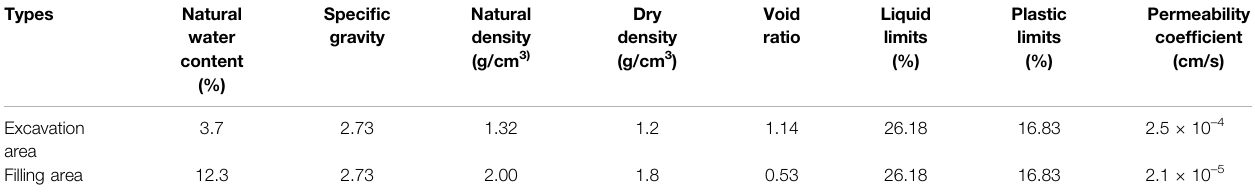
TABLE 1 | Physical properties of selected loess.